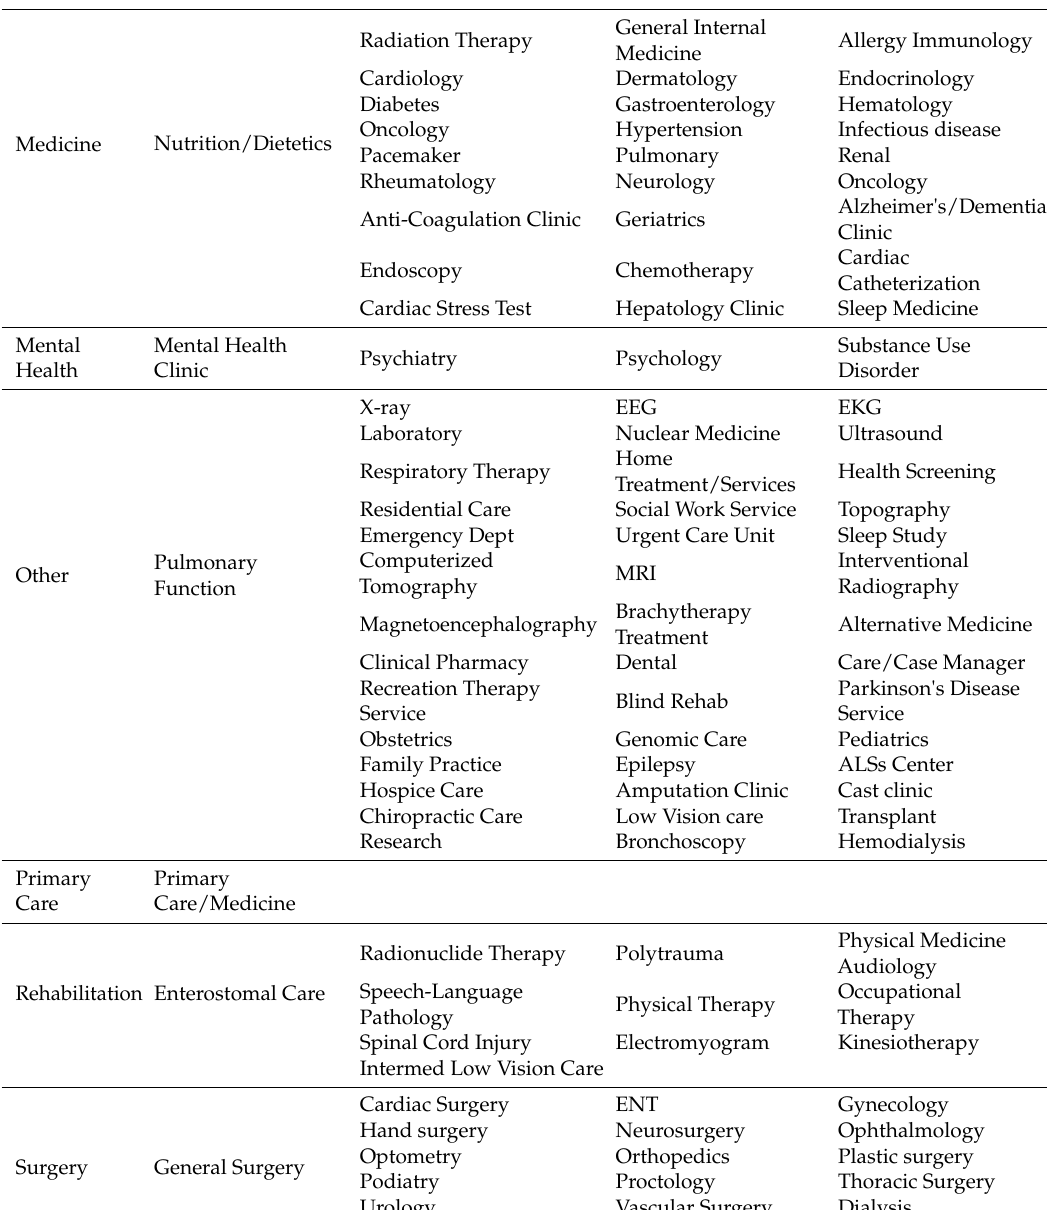
Table A1. Service line